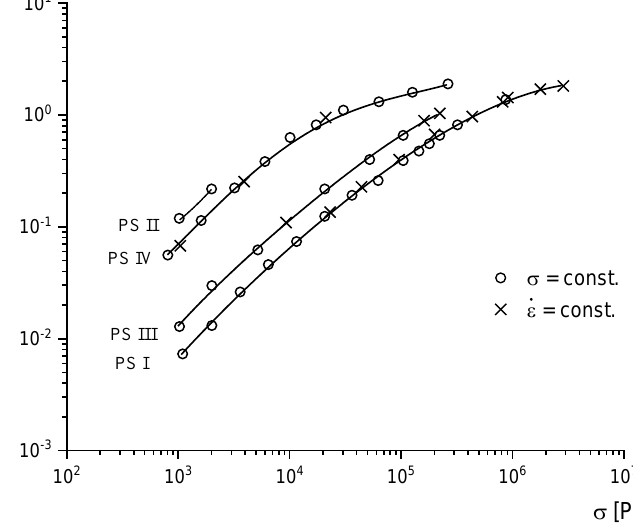
Figure 5. Steady-state recoverable elongation 𝜀 𝑟𝑠 as a function of tensile stress 𝜎 for polystyrenes with different molar mass distributions. PS I is anionically polymerized with a very narrow distribution, PS II is an anionically polymerized sample with a distinct high molar mass tail, and the anionic PS III is marked by a tail extending to lower molar masses [15]. PS IV is a commercial product with a pronounced broad distribution. The results from measurements at constant stress and constant elongational rate are in good agreement.